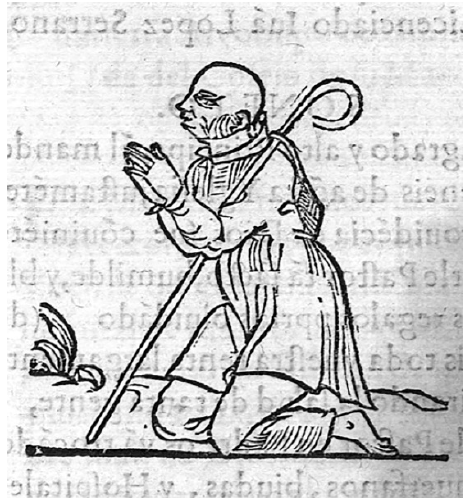
Figure 6. Anonymous. S. Juan de Dios frente a Cristo crucificado . Papal bull Licet ex debito . In Francisco de Castro: Historia de la vida y sanctas obras de Iuan de Dios … En Granada, en casa de Antonio de Librixa. Año de M.D.LXXXV, n.p.